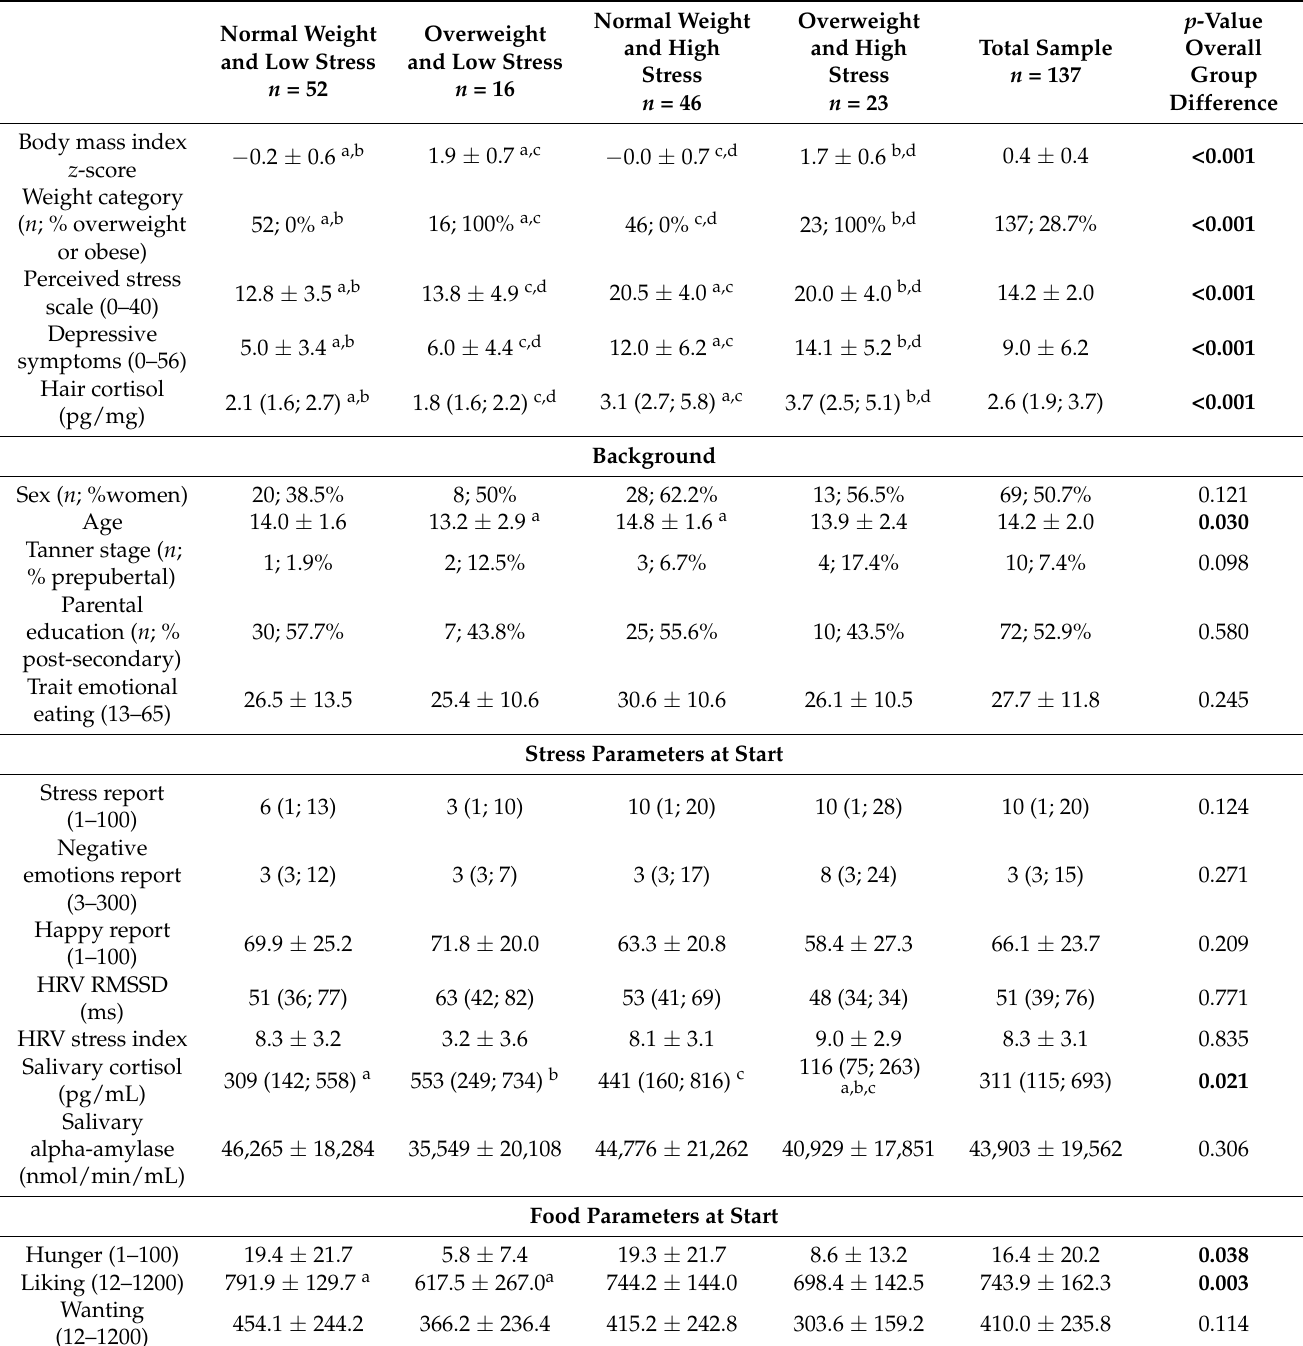
Table 1. Descriptive data and BMI/stress group differences at